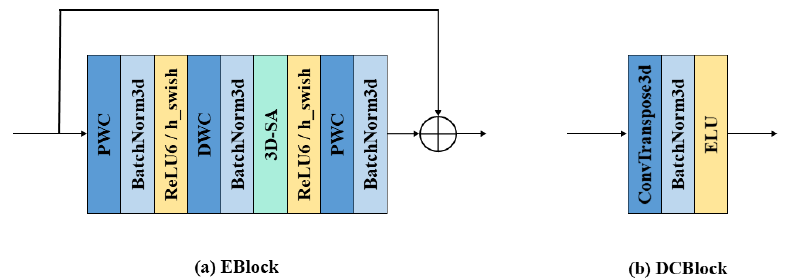
Figure 11. The basic blocks of ESA-rPPGNet. ( a ) is the basic component block of the encoder. ( b ) is the basic component block of the